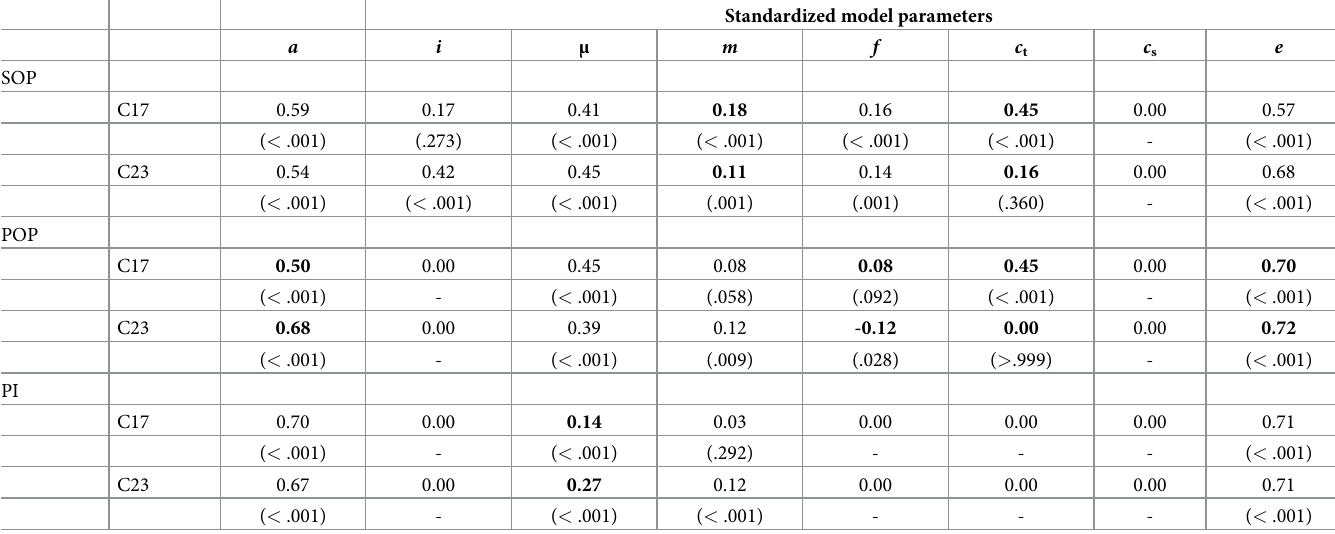
Table 3. Standardized path estimates for model parameters derived from the best fitting, most parsimonious ETFD model.